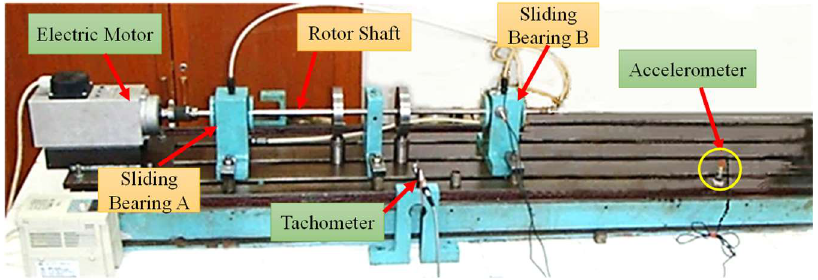
Figure 15. Sliding-bearing test rig for shaft-bending fault experiments.